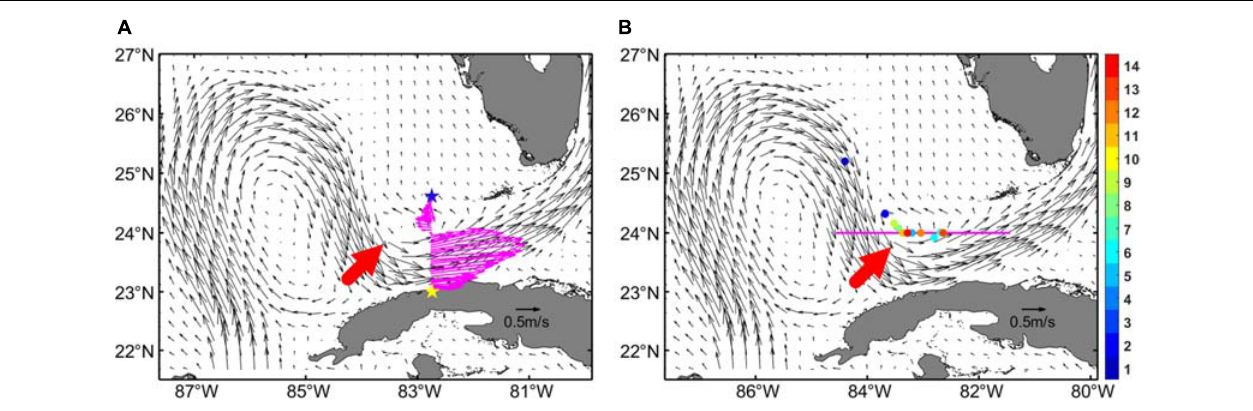
FIGURE 6 | Distribution of mean global HYCOM surface currents (black vectors in A,B ) over phases 3–14 (April 23 to July 15, 2017), during which the TE annotated with a thick red arrow was quasi-stationary off the DT. (A) is same to Figure 2J . The ADCP-based currents (vertically averaged over the layer of ∼ 5–10 m) collected between May 24 and 25, 2017 are overlaid as thin magenta vectors in (A) . The yellow and blue pentagrams in (A) denote the start and end points of the ship’s track. The eddy centers are determined by the AMEDA algorithm based on weekly mean model surface current velocities during phases 1–14 (shown in Figure 5 , April 9 to July 15, 2017) and are denoted by colored dots in (B) , where the time (phase, represented by week number) is color coded. A horizontal section passing through the center of the simulated TE is annotated with magenta color in (B) , along which the vertical structures of mean simulated temperature, salinity, density, and the squared buoyancy frequency from April 23 to July 15, 2017 are presented in Figure 9 .